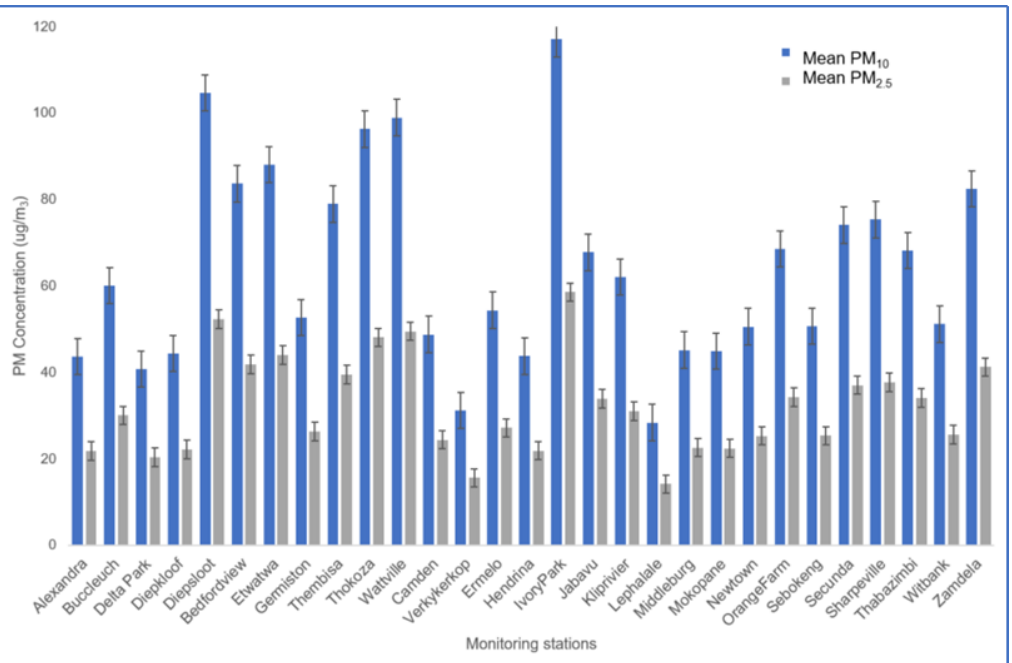
Figure 3. Mean annual PM concentrations by monitoring station.